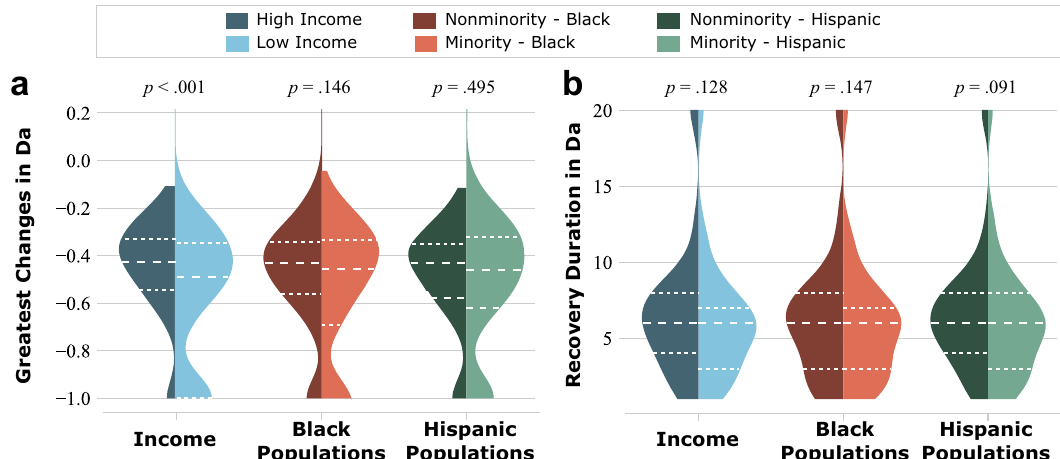
Fig. 4 Distribution of the two assessment features of activity density in terms of the income, race, and ethnicity. The two assessment features includes a the greatest changes and b recovery duration. Results show that census tracts having more low-income or minority groups were experiencing signi fi cant impacts in terms of the extent (more negative changes) and duration (longer recovery duration) of the power outages than census tracts having high- income and nonminority groups.